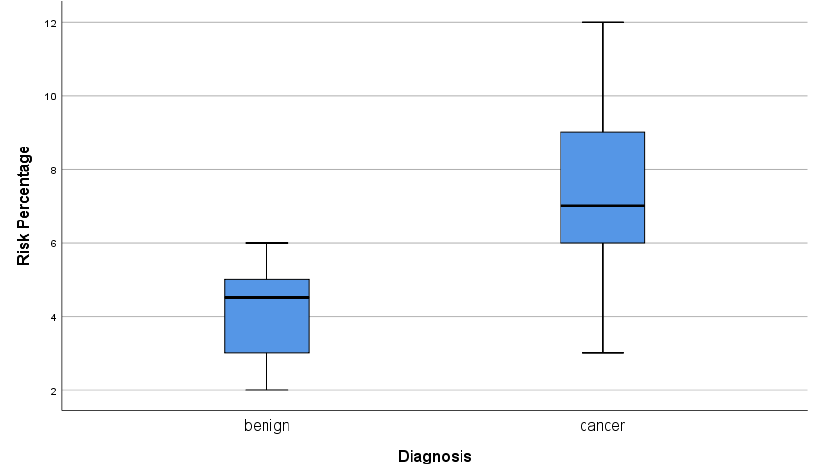
Figure 12. Diagnosis–risk percentage box plot.